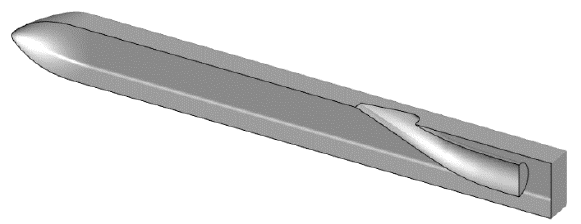
Figure 8. Reference [40] Submerged inlet.